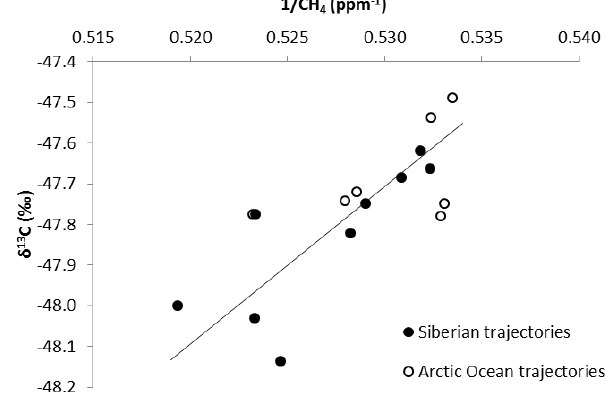
Figure 6. Keeling plot for observations carried out at ZEP obser- vatory in September–October 2009. Only the observations with a dominant origin from ESAS and Siberia or from the Arctic Ocean are kept here. The y axis intercept of the Keeling plot is − 62 ±